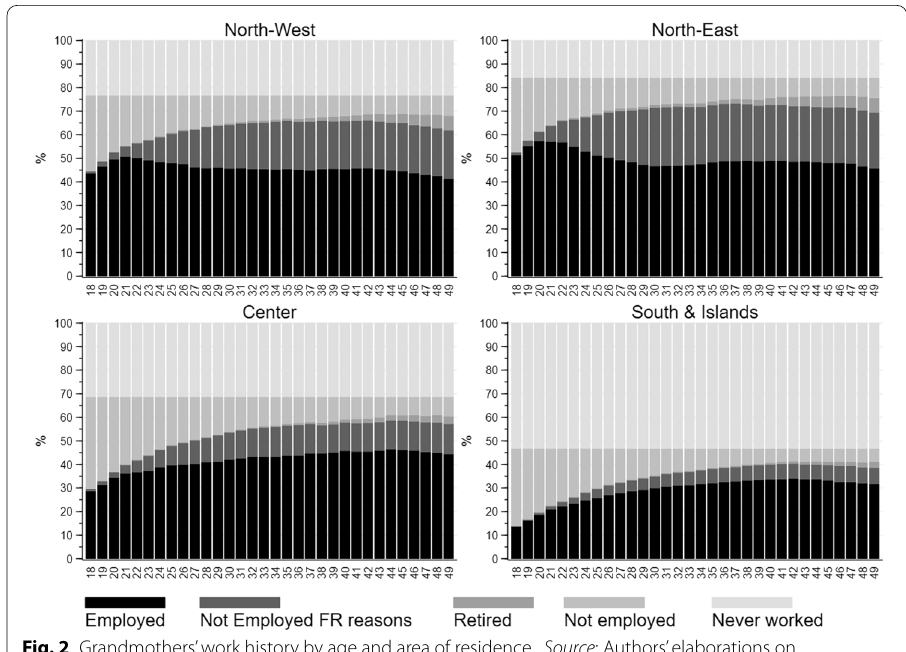
Fig. 2 Grandmothers’ work history by age and area of residence. Source : Authors’ elaborations on Multipurpose surveys on Families and Social Subjects—ISTAT, 2003, 2009, 2016. N